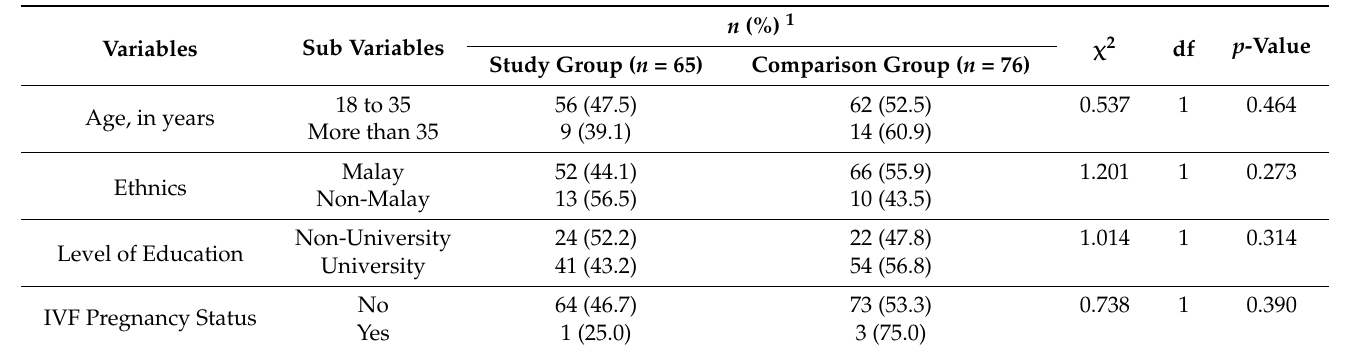
Table 2. Participants’ baseline differences ( n = 141).